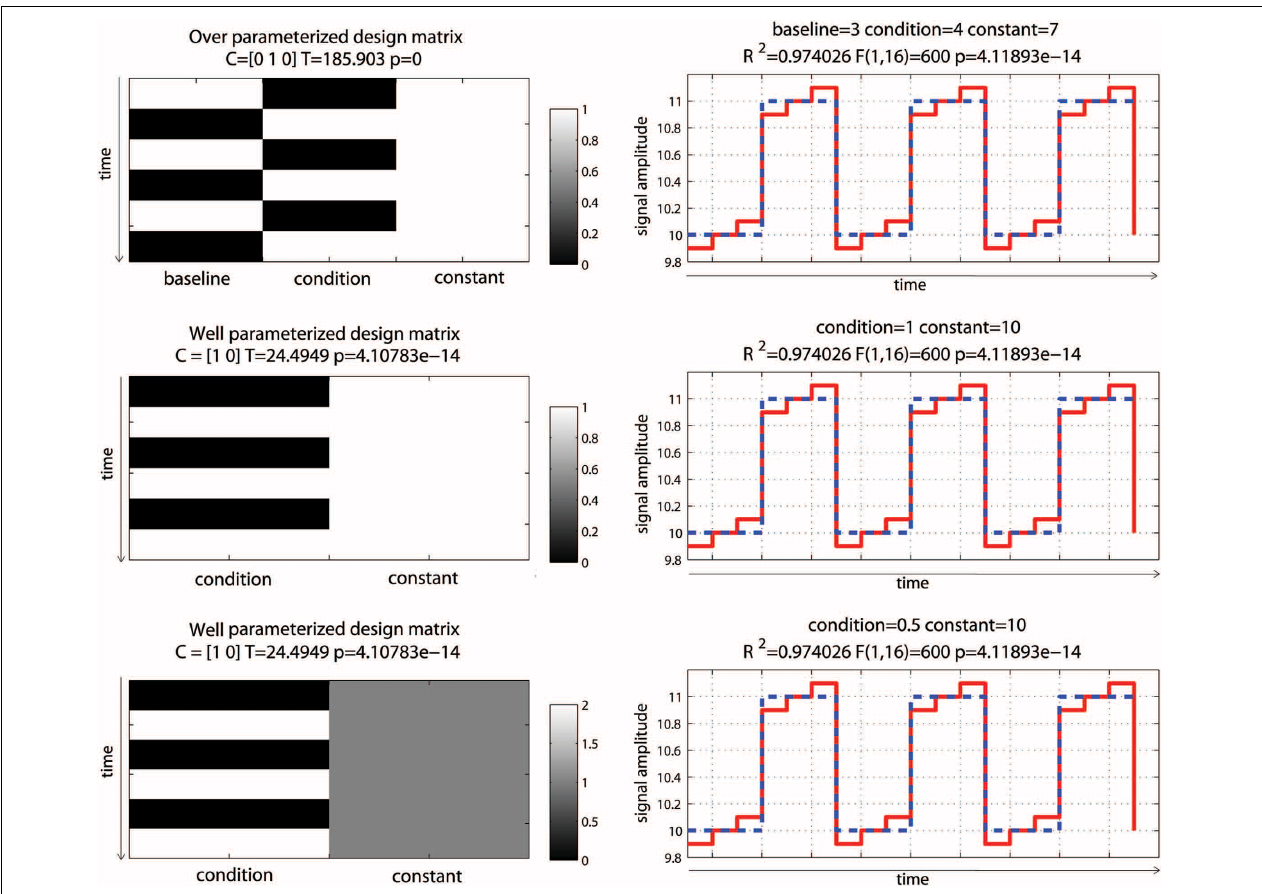
FIGURE 2 | Controlled block design with a single “active” condition above baseline. Three different models were used: one over-para meterized one (baseline and condition were modeled— top ), and two well-parameterized ones (only the condition was modeled) but with the design matrix value either between 0 and 1 (middle) or 0 and 2 (bottom) . As illustrated on the right hand side, all 3 models (dashed